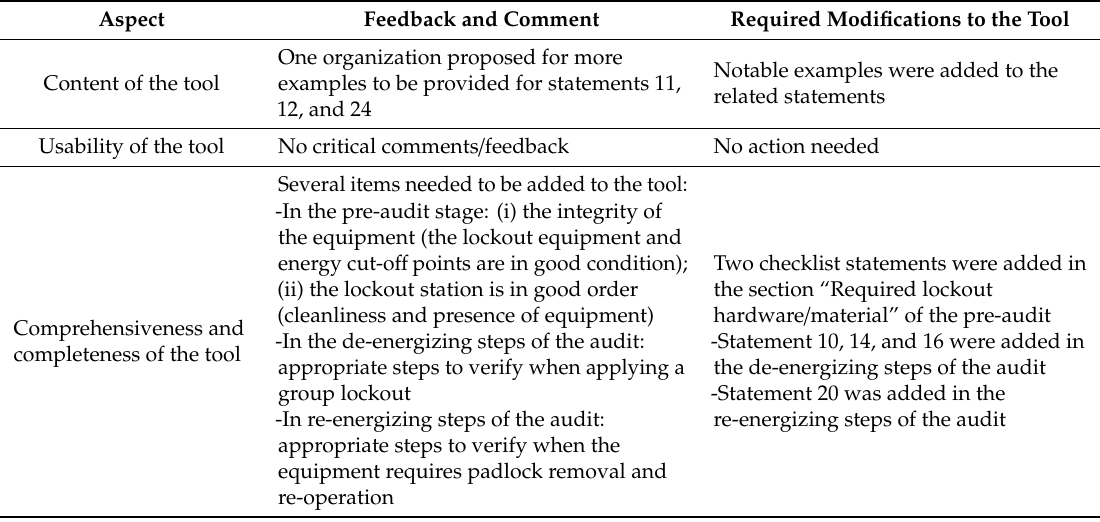
Table 6. Main feedback and comments by the organizations on the self-audit tool in terms of content validity, and required modifications to the